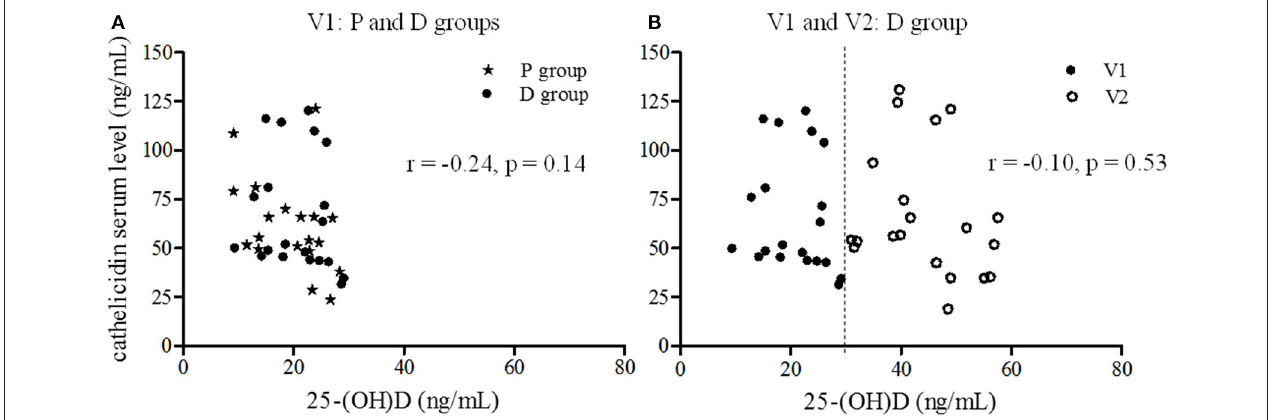
FIGURE 4 | Correlation between 25-(OH)D and cathelicidin serum levels. The relationship between cathelicidin and 25-(OH)D serum levels was estimated using Pearson correlation. (A) Correlation at inclusion (V1) for all volunteers (star P group, circle D group) ( r = − 0.24, p = 0.14). (B) Correlation before (V1: dark circle) and after the supplementation period (V2: light circle) for D group ( r = − 0.10, p = 0.53).